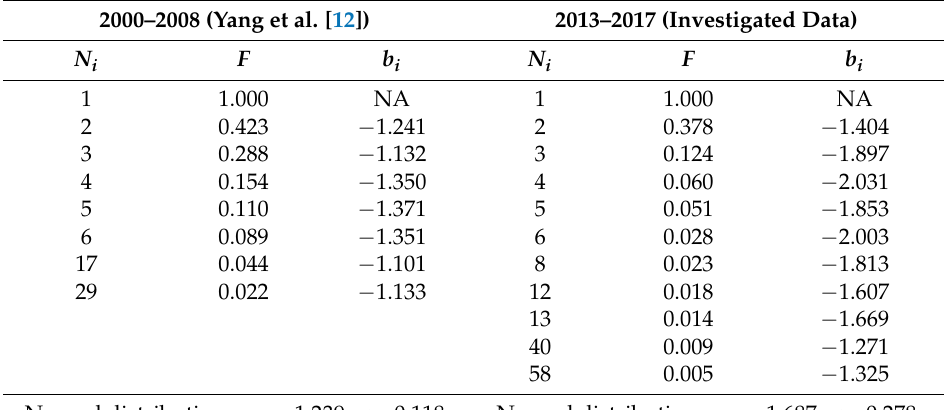
Table 4. Accumulated frequency of hazardous material accidents occurred in road transportation with N deaths from Yang et al. [12] and investigation in different periods of China.